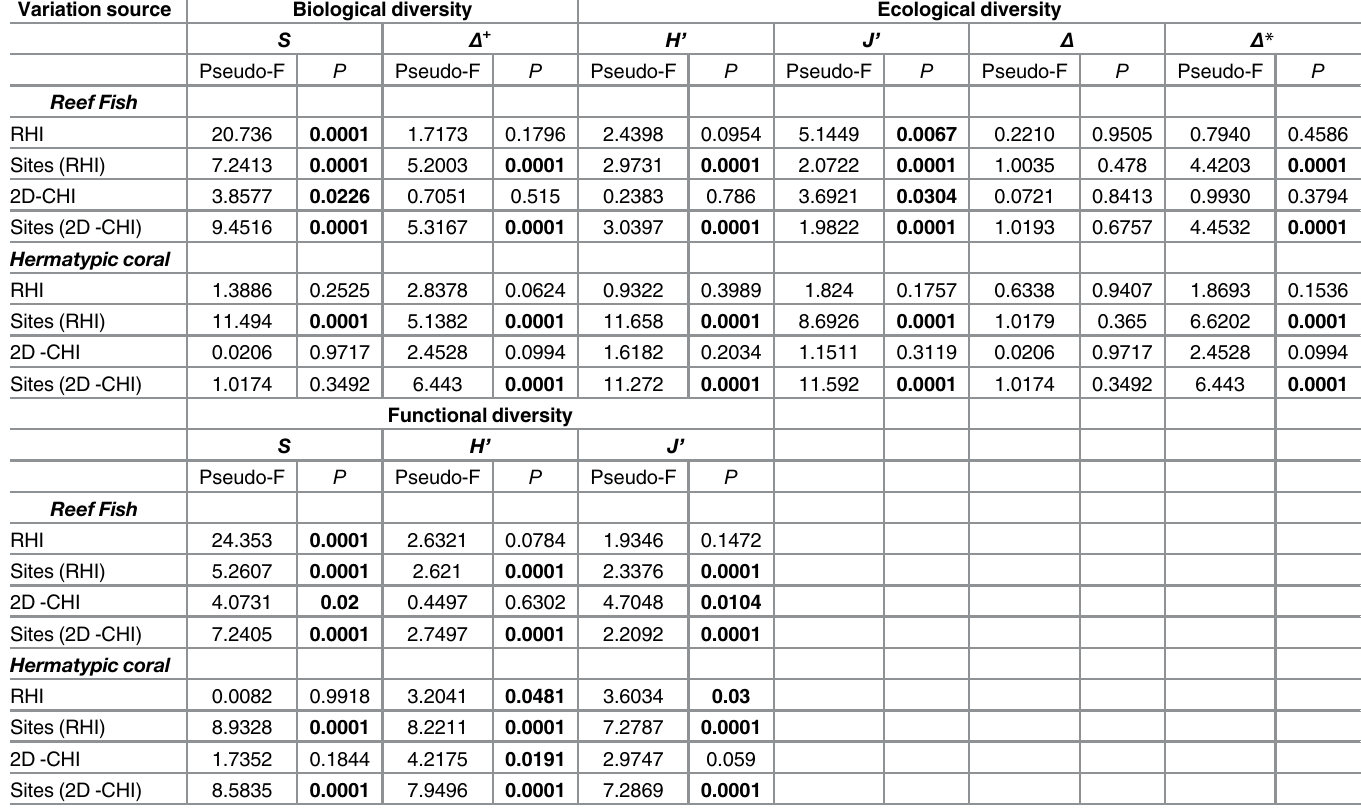
Table 2. Two-way nested and permutational ANOVAs (Model 2) outcomes contrasting the biological, ecological and functional diversity of fish and corals among different health grades of the RHI and 2D-CHI indices and among sites nested in the health indices. Variation